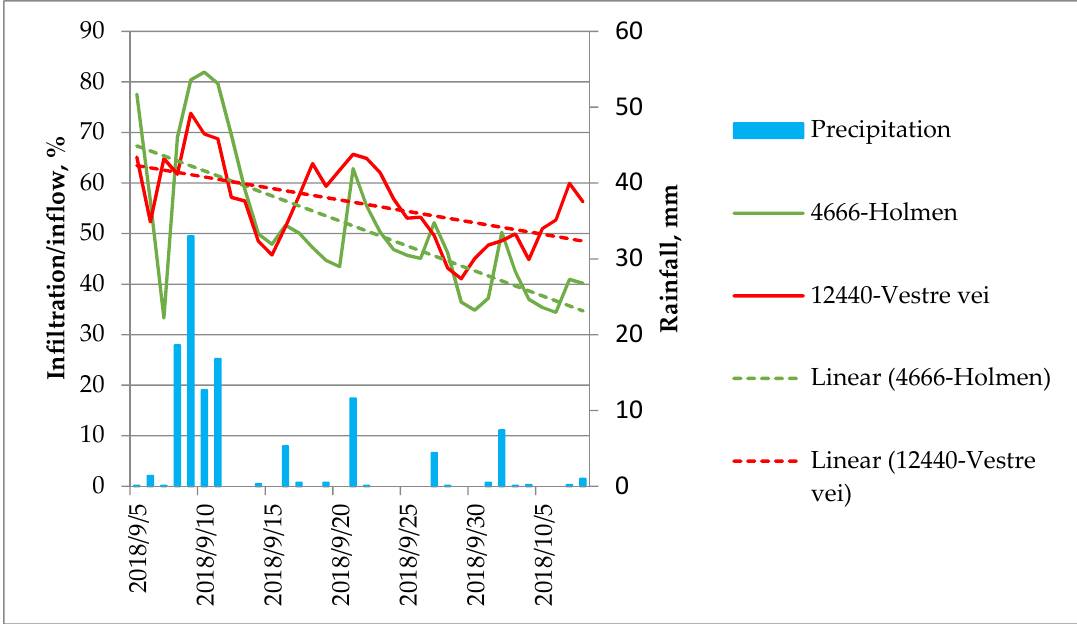
Figure 11. Calculated share of I/I-water in Holmen and Vestre vei in a wet weather period, before the implementation of the measures.